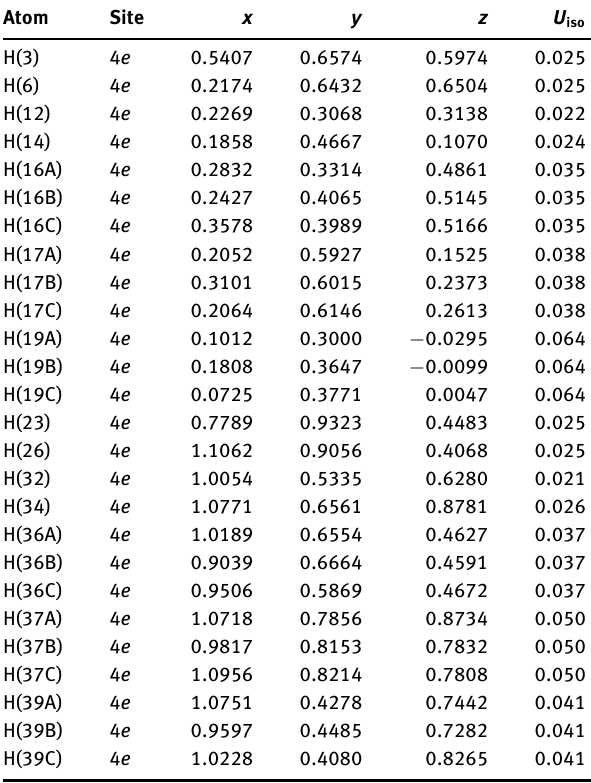
Table 2: Fractional atomic coordinates and isotropic or